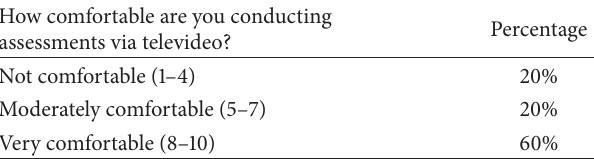
Table 2: Comfort with conducting assessments via televideo ( 𝑛 = 25 ).